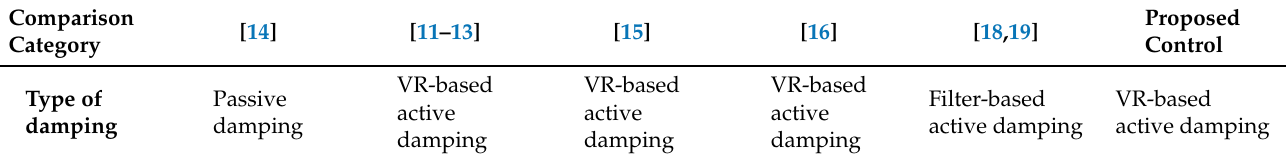
Table 2. Existing AC-side control methods compared with the proposed control